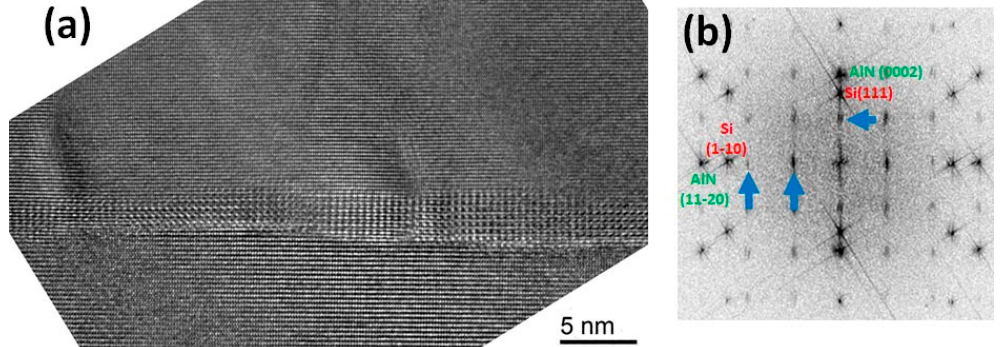
Figure 5. ( a ) HRTEM on AlN/Si interface. Zone axis = Si<11-2>/AlN<10-10>; ( b ) FT of image ( a ); some diffraction spot indexations are indicated in green for AlN and red for Si. The blue arrows point out extra diffraction spots.